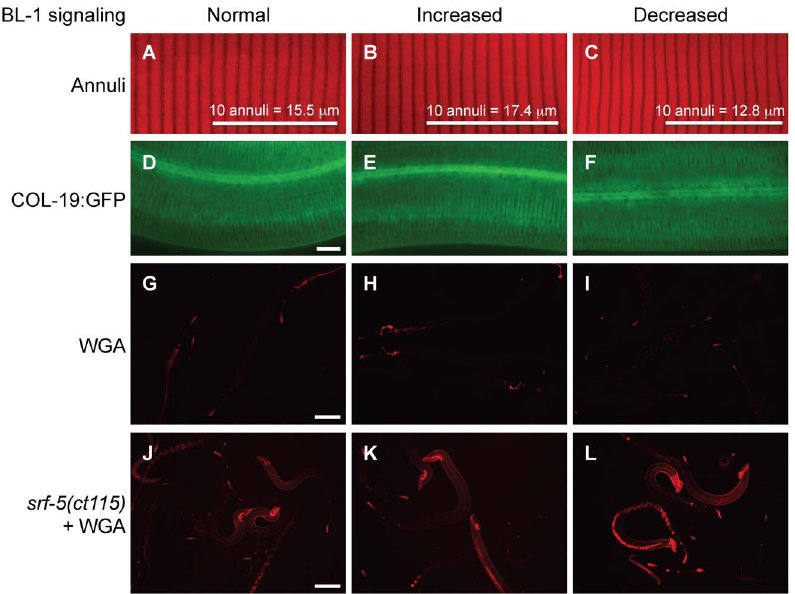
Figure 4. DBL-1 signaling affects specific cuticular surface properties. (A–C) Rhodamine-conjugated wheat germ agglutinin (WGA) staining in wild-type (A), dbl-1( ++ ) (B), and dbl-1(nk3) (C) populations. Scale bar=100 m m. (D–F) WGA staining in him-5(e1490); srf-5(ct115) animals with C06C3.5(RNAi) (pseudogene control RNAi) (D), lon-2(RNAi) (E), and dbl-1(RNAi) (F). Scale bar=100 m m. (G–H) Staining of annuli in wild-type (G), dbl- 1( ++ ) (H), and dbl-1(nk3) (I) animals. Bars mark the length of 10 annuli and indicate the average length of 10 annuli for each strain. (J–L) COL-19:GFP expression in otherwise wild-type animals with C06C3.5(RNAi) (pseudogene control RNAi) (J), lon-2(RNAi) (K), and dbl-1(RNAi) (L). Scale bar=10 m m.